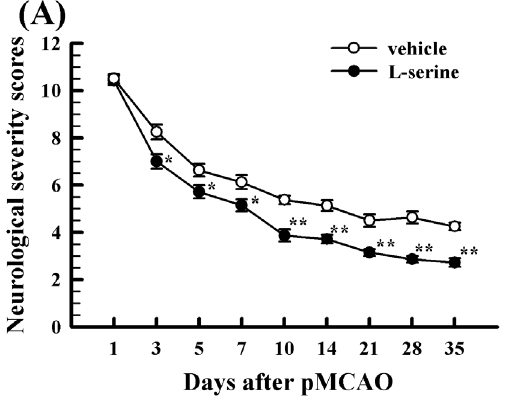
Figure 3. Effect of L-serine treatment on the behavioural tests in rats after pMCAO (n=6). Neurological severity scores were measured from day 1 to day 35 after pMCAO.